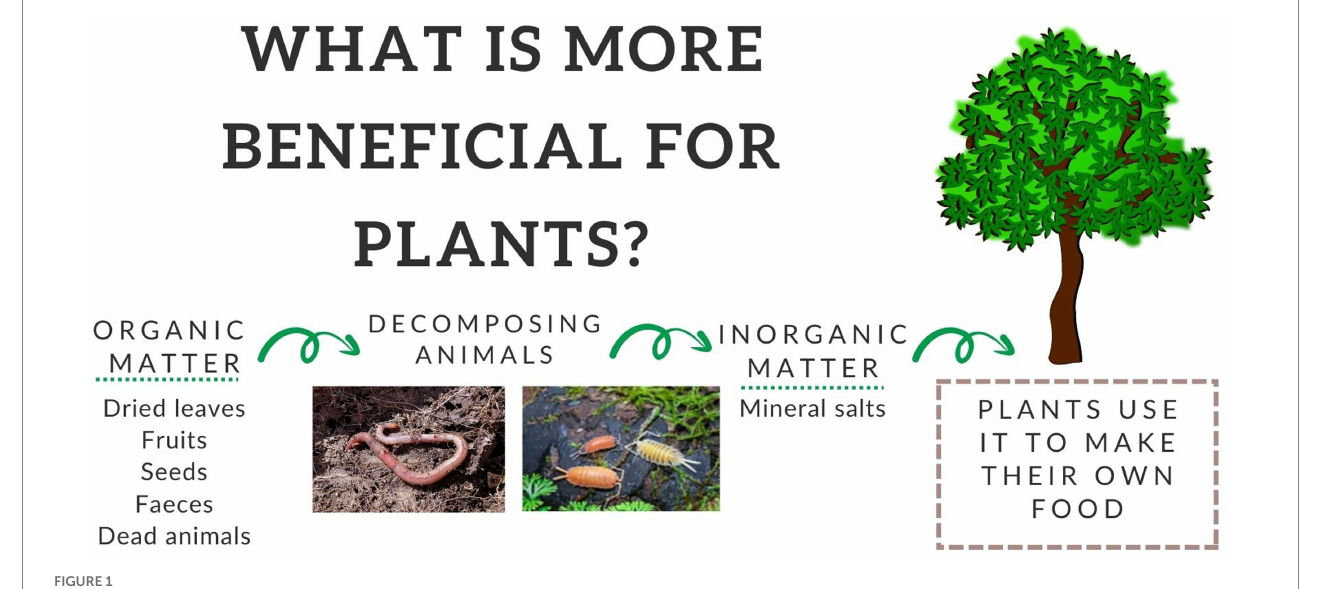
FIGURE 1 Example of digitally visual material.